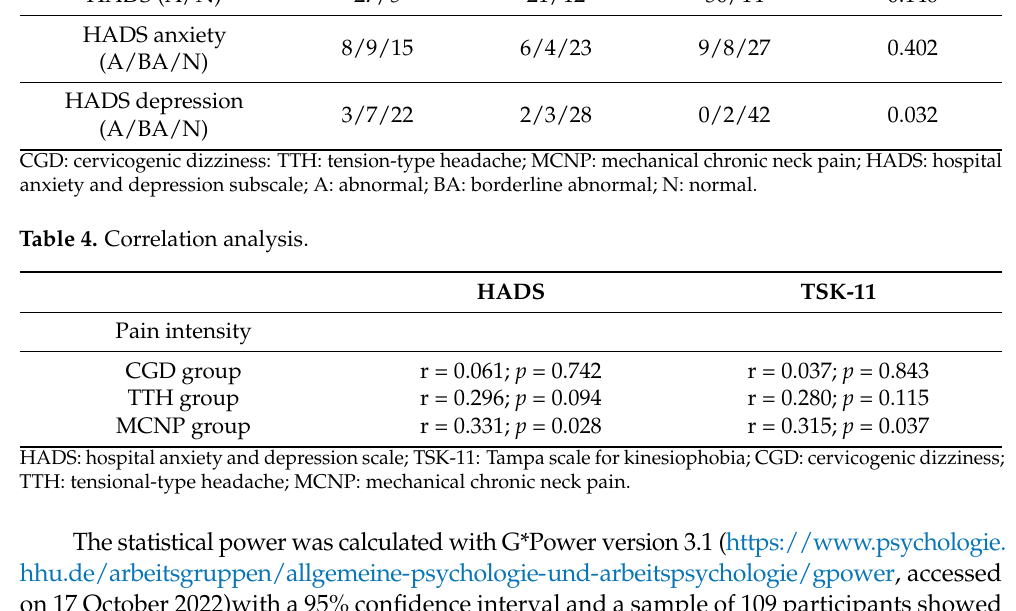
Table 3. Frequency of psychological distress in the three groups.